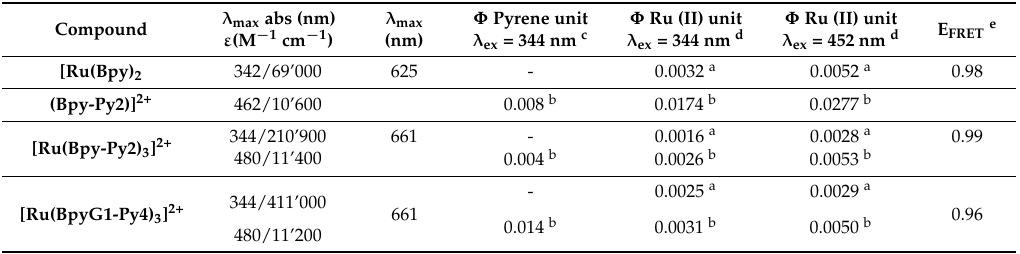
Table 5. Absorption coefficients, quantum yields, and FRET efficiencies of the ruthenium-pyrene constructs “Reprinted from Polymers, 99, Vonlanthen, M.; Cevallos-Vallejo, A.; Aguilar-Ort í z, E.; Ruiu, A.; Porcu, P.; Rivera, E., Synthesis, characterization and photophysical studies of novel pyrene labelled ruthenium (II) trisbipyridine complex cored dendrimers, 13–20, Copyright (2016), with permission from Elsevier”